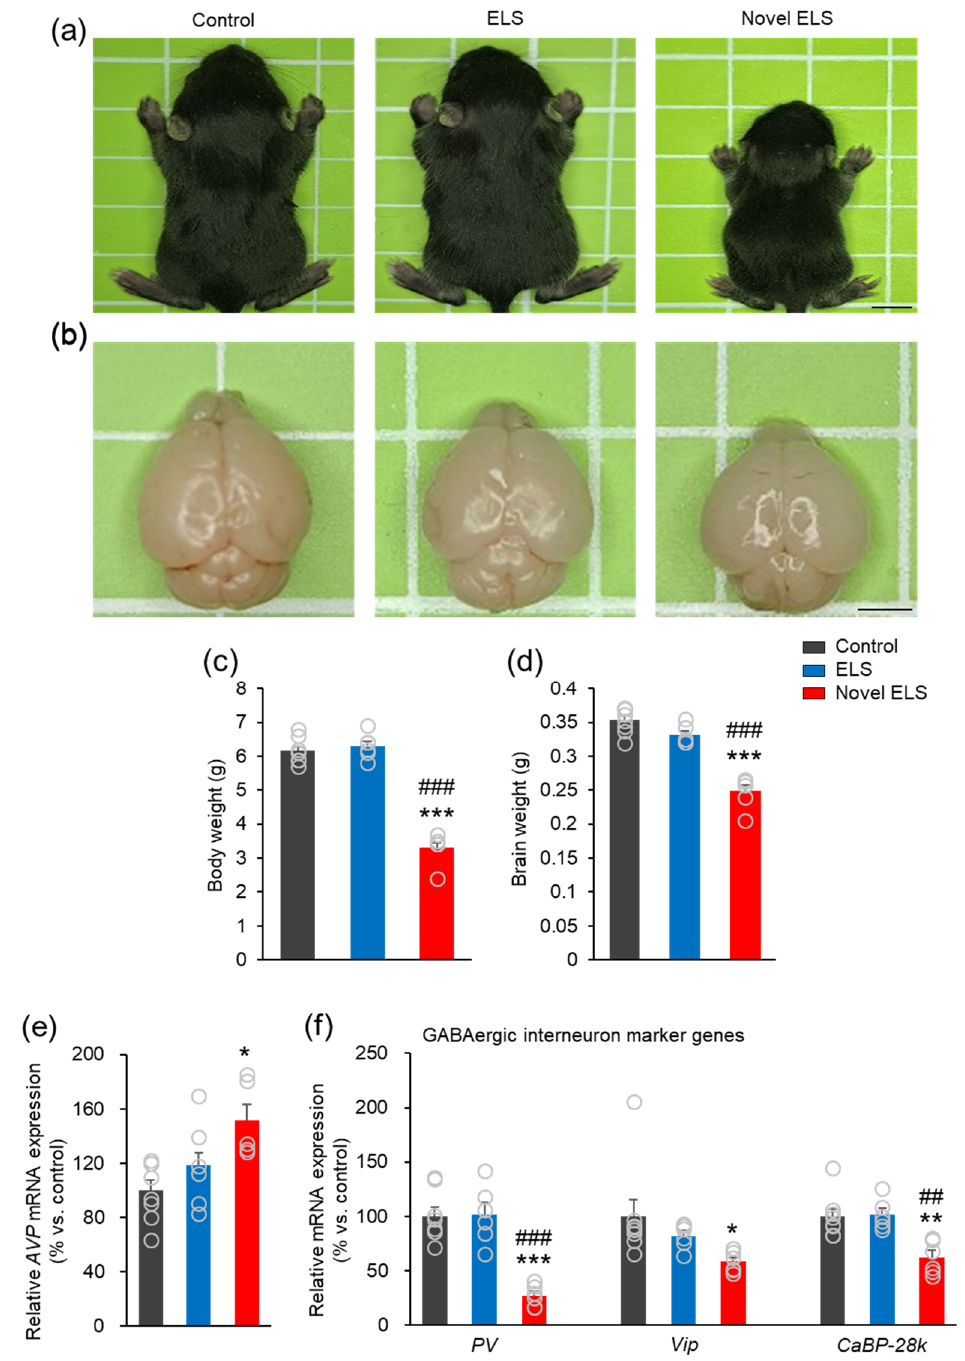
Figure 4. Novel ELS inhibits mouse growth and alters gene expression related to stress and GABAergic interneurons. ( a , b ) Representative image of the postnatal day 14 (P14) mouse body and brain for the control, established ELS, and novel ELS groups. ( c , d ) P14 offspring mouse body and brain weight. Scale bar = 5 mm (body image) and 3 mm (brain image). Statistical significance was determined using one-way ANOVA, with Bonferroni’s correction. *** p < 0.001 vs. vehicle, ### p < 0.001 established ELS vs. novel ELS. ( e , f ) Quantification analysis of AVP , GABAergic interneuron marker gene expression in the P14 offspring mice whole brains through quantitative real-time PCR. Statistical significance was determined using one-way ANOVA, with Bonferroni’s correction. Gene expression was normalized using the mRNA content of GAPDH. * p < 0.05 and ** p < 0.01 vs. vehicle, *** p < 0.001 vs. vehicle, ## p < 0.01 and ### p < 0.001 established ELS vs. novel ELS. Data represent mean ± SEM.